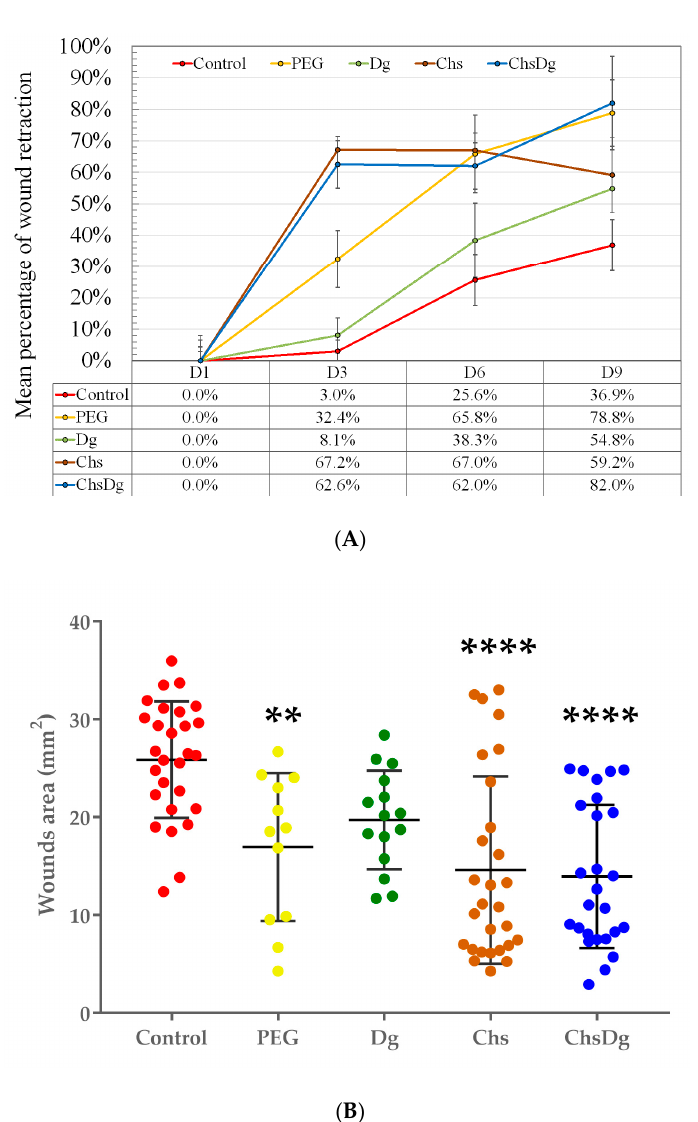
Figure 3. Dynamics of wound areas reduction during treatment with various combinations ( A ).